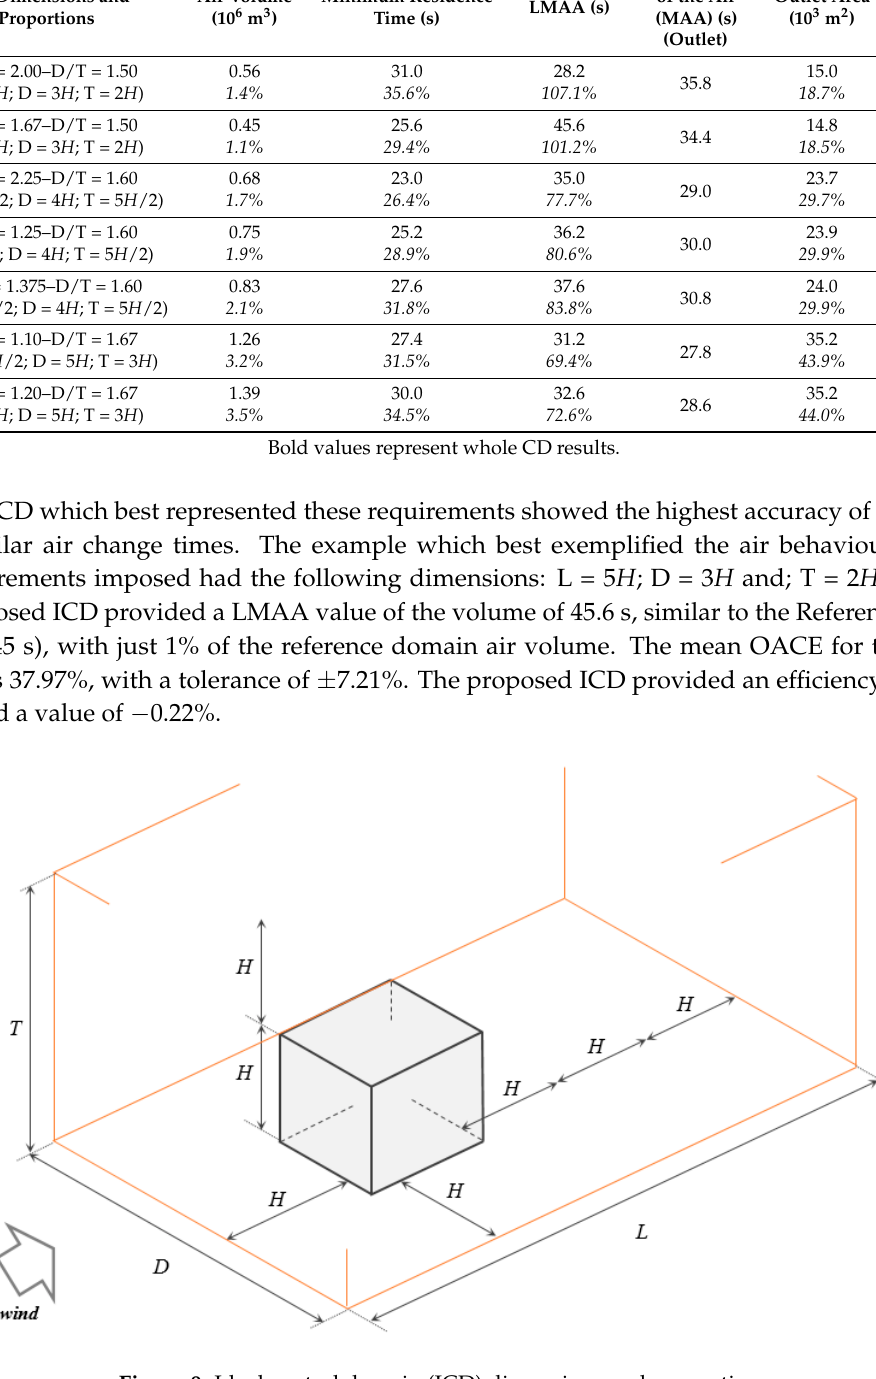
Figure 9. Ideal control domain (ICD) dimensions and proportions.